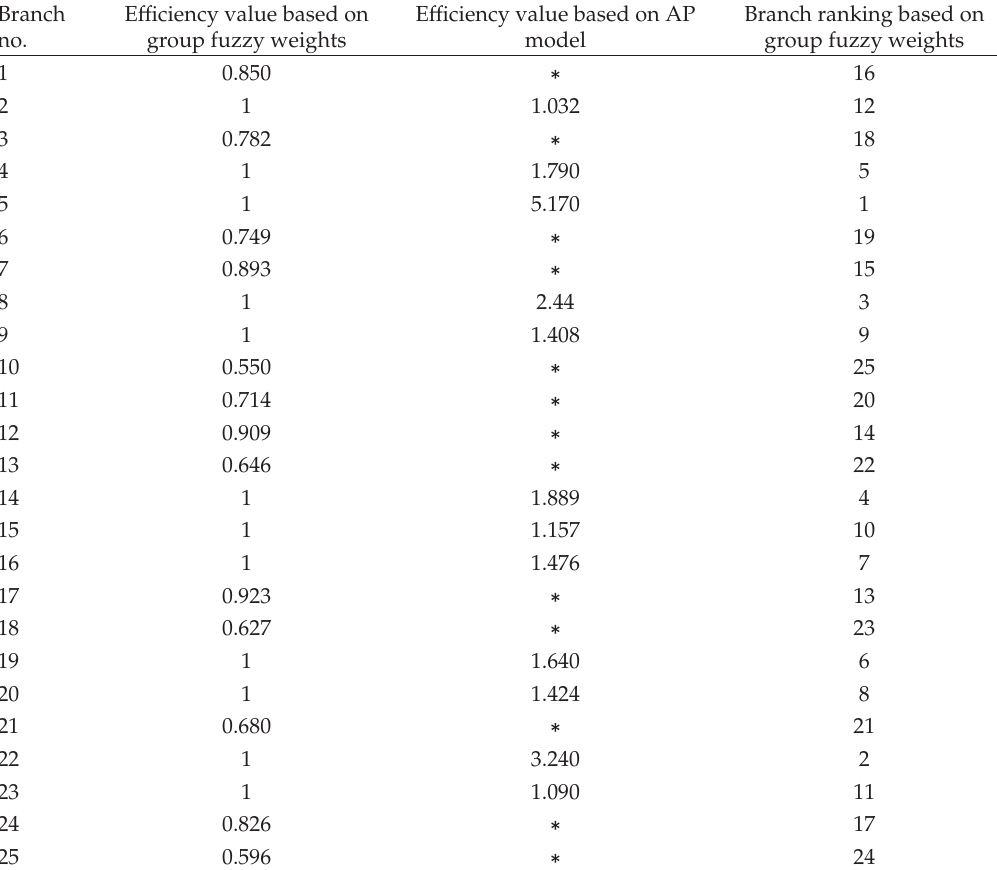
Table 5: E ffi ciency value of DMUs based on group fuzzy